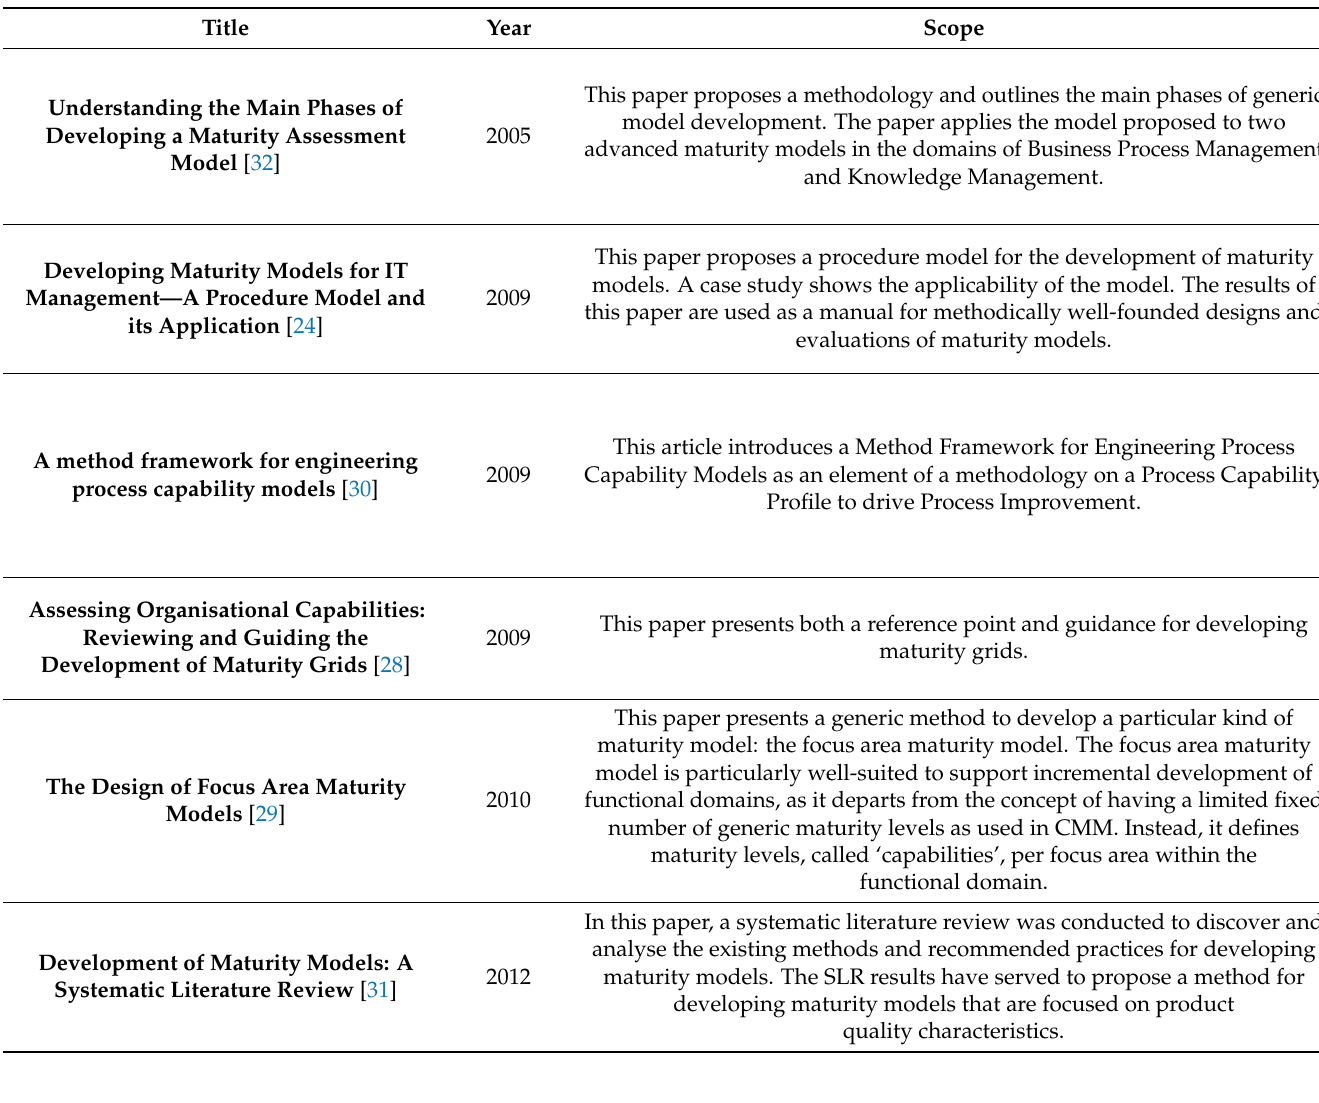
Table 1. Studies available in the literature for the maturity model